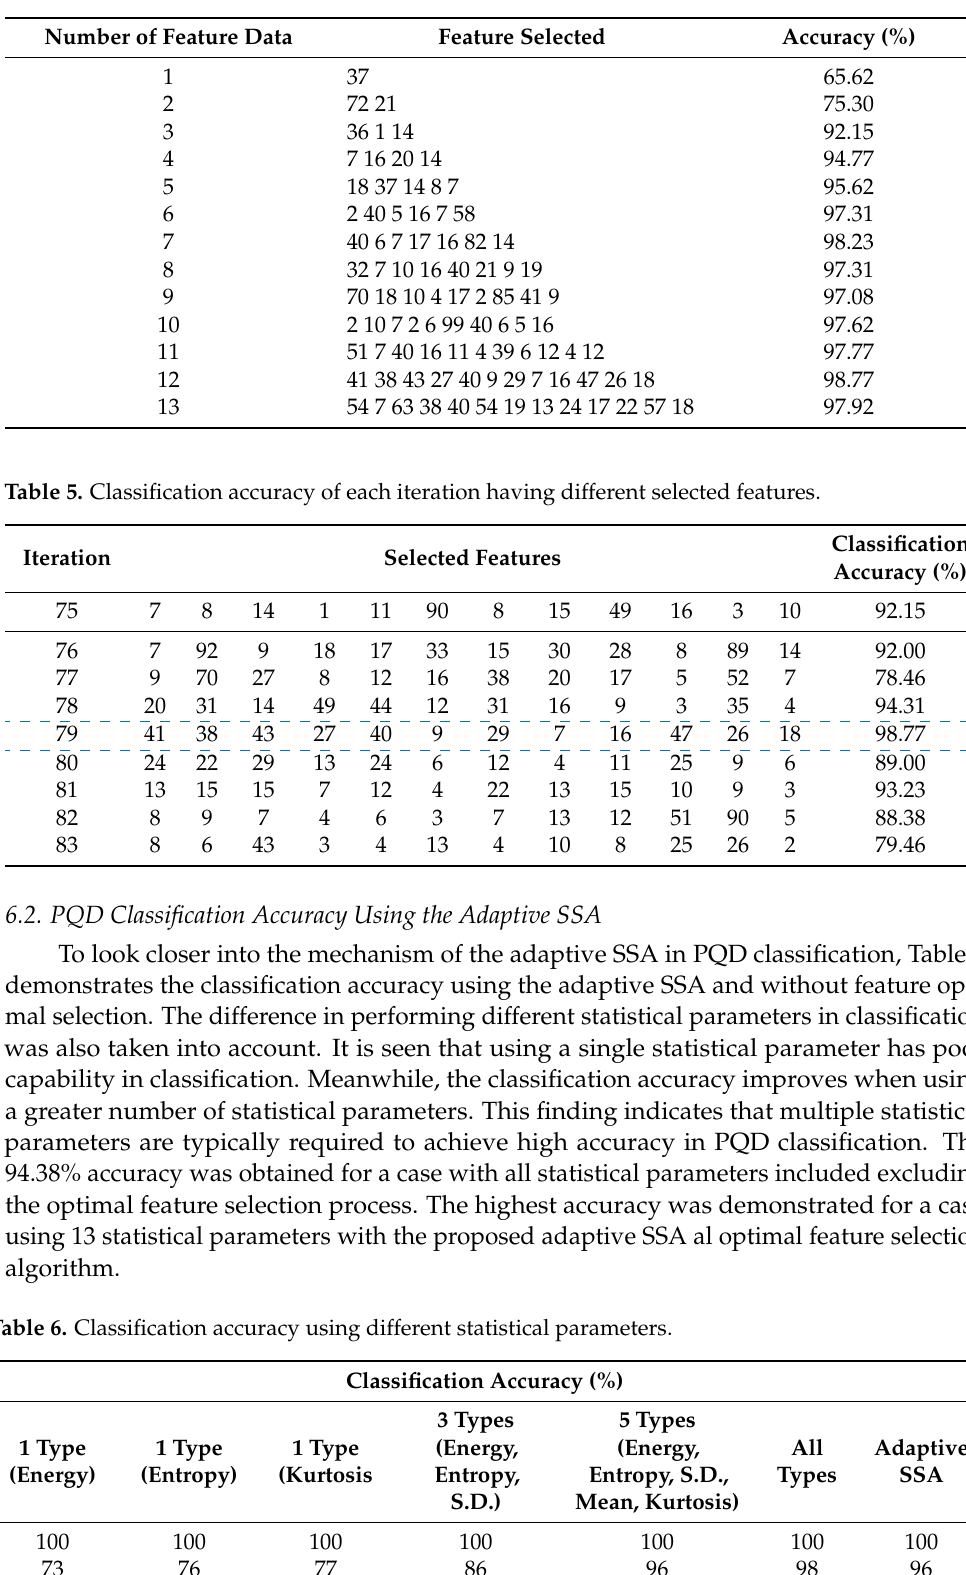
Table 4. Classification accuracy with different numbers of features selected.